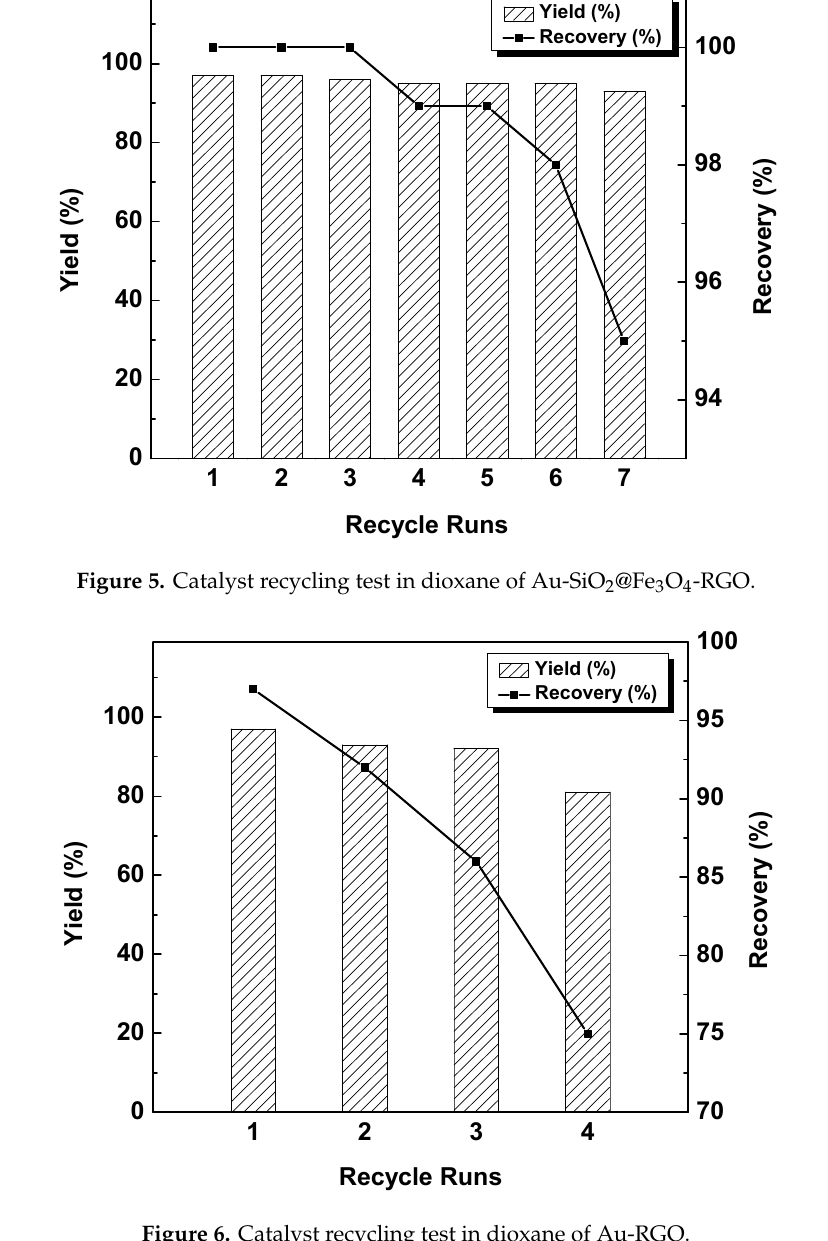
Figure 6. Catalyst recycling test in dioxane of Au-RGO.